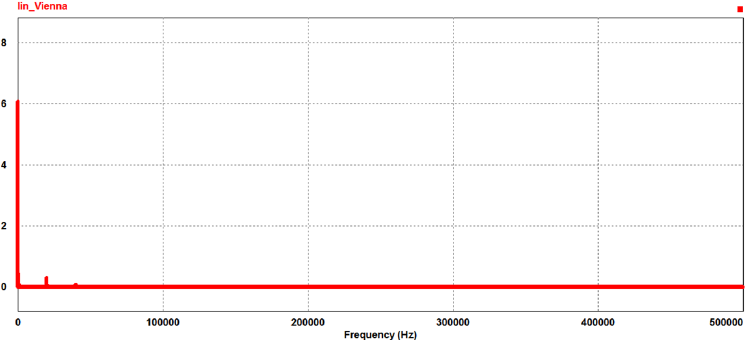
Figure 19. FFT analysis of the input current waveform of an IH system with the MVR.